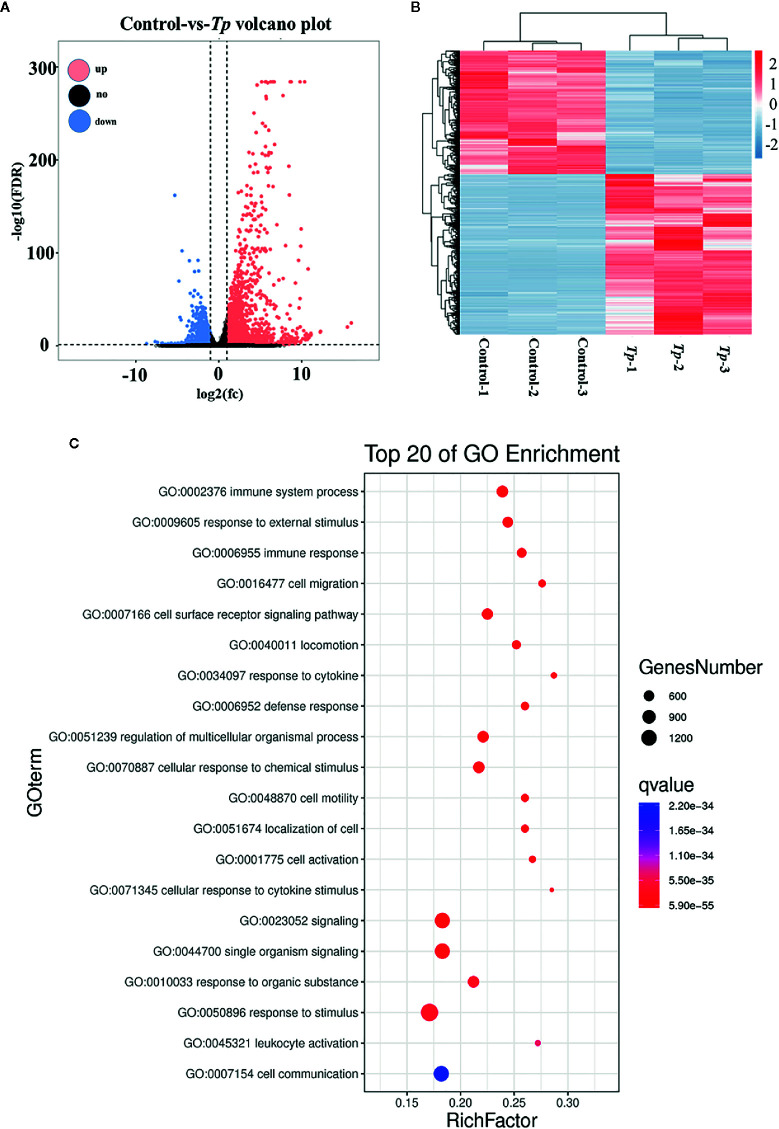
Differential expression of mRNAs in cells between the Tp and control groups. The volcano plots (A) and heatmap (B) demonstrate the differentially expressed mRNAs between the Tp-exposed THP-1 cells and PBS-treated control cells. In total, 1,477 mRNAs were significantly upregulated, and 1,137 mRNAs were significantly downregulated in the Tp-exposed THP-1 cells compared with control cells. The red dots indicate the mRNAs with upregulated expression, the blue dots indicate the mRNAs with downregulated expression, and the black dots indicate the mRNAs with no significant differences between groups. mRNAs with an expression fold change >2 and with an FDR-adjusted P < 0.05 were considered statistically significant. (C) GO analysis evaluated the pathways enriched by the top 20 dysregulated mRNAs.